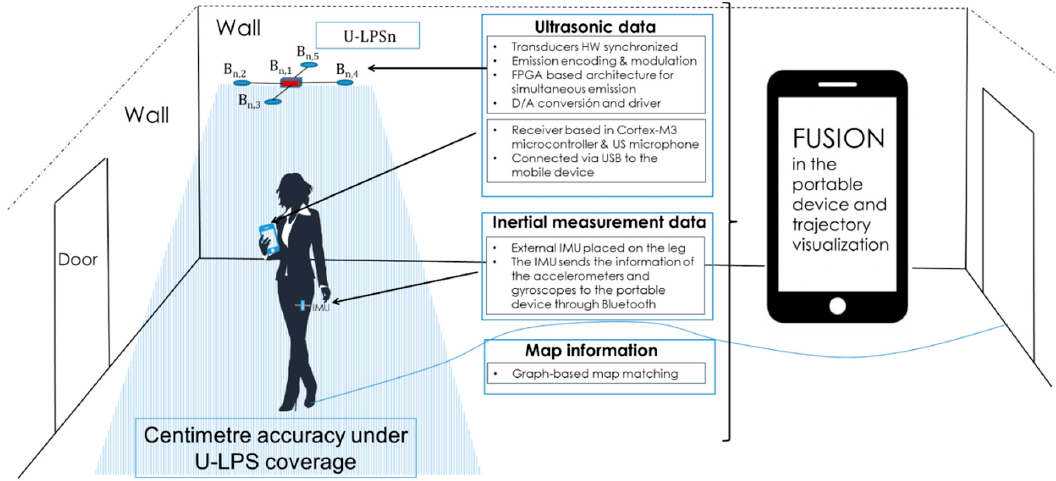
Figure 1. General diagram of the data to be processed in the mobile device for indoor positioning (The woman is designed by Showeet.com, accessed on 8 March 2021).